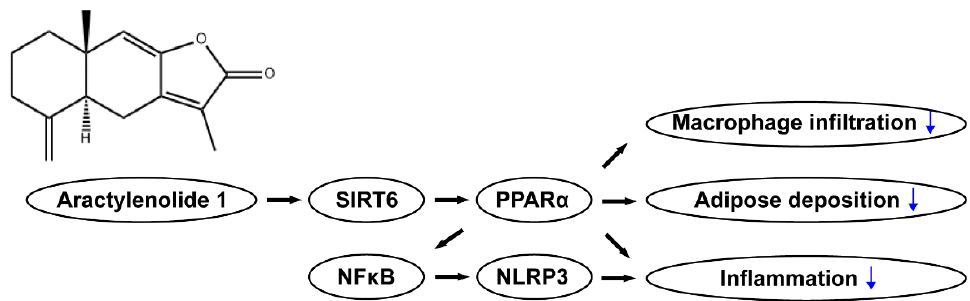
Figure 8. Schematic diagram demonstrating how ATL I alleviates hepatic